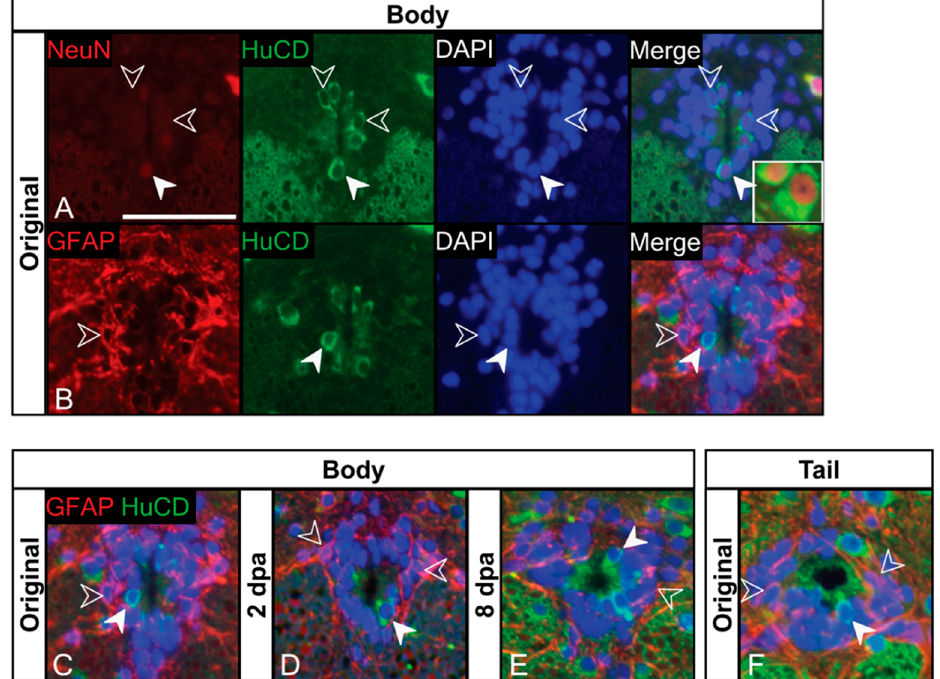
Figure 5. Trunk spinal cord ependymal cells represent a heterogeneous population with distinct GFAP+ and HuCD+ populations. ( A ) HuCD+ cells are present within the trunk spinal cord and are in close contact with the central canal. HuCD+ cells have either weak (filled arrow) or absent NeuN expression (open arrows). Note that NeuN expression in HuCD+/NeuN+ cells does not reach the intensity of NeuN expressing neurons of the grey matter (inset). ( B ) The ependymal layer of the trunk spinal cord contains distinct populations of GFAP+/HuCD–cells (open arrows) and GFAP–